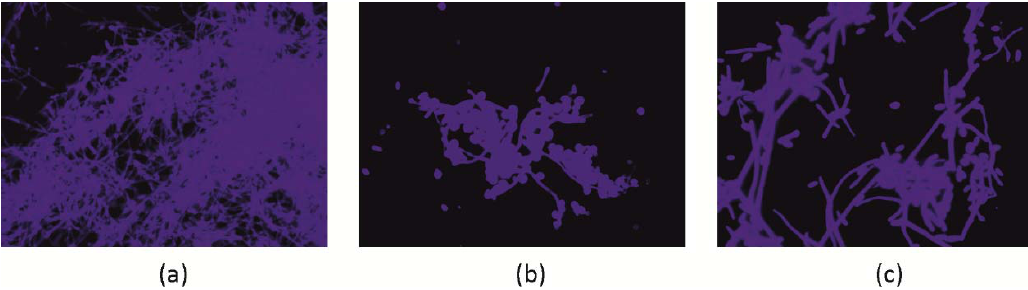
Figure 5. Mycelium of C. albicans ATCC10231 formation after 24 h exposure to SBT twig-derived fractions. ( a ) control; ( b ) GF, ( c ) GL at 0.5× MIC. C. albicans mycelium stained with Calcofluor White was checked microscopically (fluorescence microscope, Zeiss, AXIO Scope A1, magnification 400×); representative images are shown.